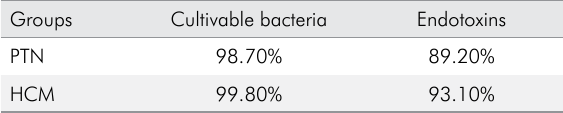
Table 3. Percentage reduction values of cultivable bacteria and endotoxins found in primarily infected root canal after PTN or HCM instrumentation.